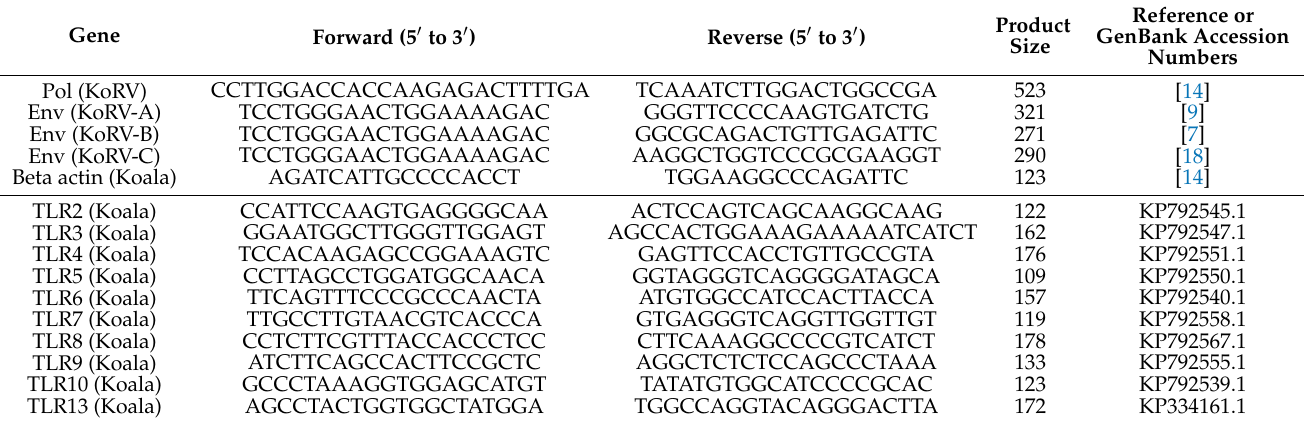
Table 1. Primers used for the detection of Koala retrovirus (KoRV) (subtypes) and toll-like receptors (TLRs) gene expression